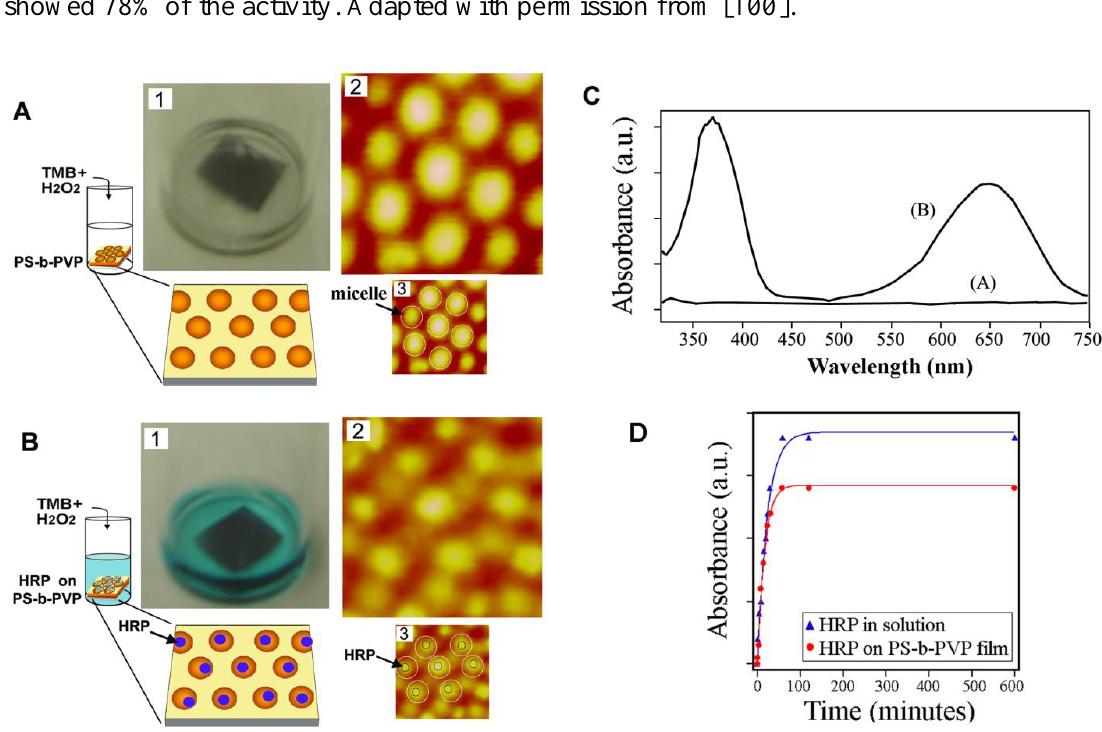
Figure 6. Quantitative and qualitative HRP activity measurements on PS- b -PVP nanodomains. ( A ) Control experiment without HRP molecules on PS- b -PVP. ( B ) (1) Assay carried out with HRP molecules on PS- b -PVP. AFM panels in (A) and (B) are 180 × 180 nm in scan size. ( C ) (A) No absorbance peaks from the control experiment involving only the PS- b -PVP template. (B) Characteristic UV/VIS absorbance peaks were monitored due to HRP bound on PS- b -PVP. ( D ). UV/VIS absorbance of HRP molecules monitored over time in solution (data shown in blue) and on PS- b -PVP micelles (data shown in red). When compared to the activity of HRP molecules in solution, HRP molecules bound on PS- b -PVP showed 78% of the activity. Adapted with permission from